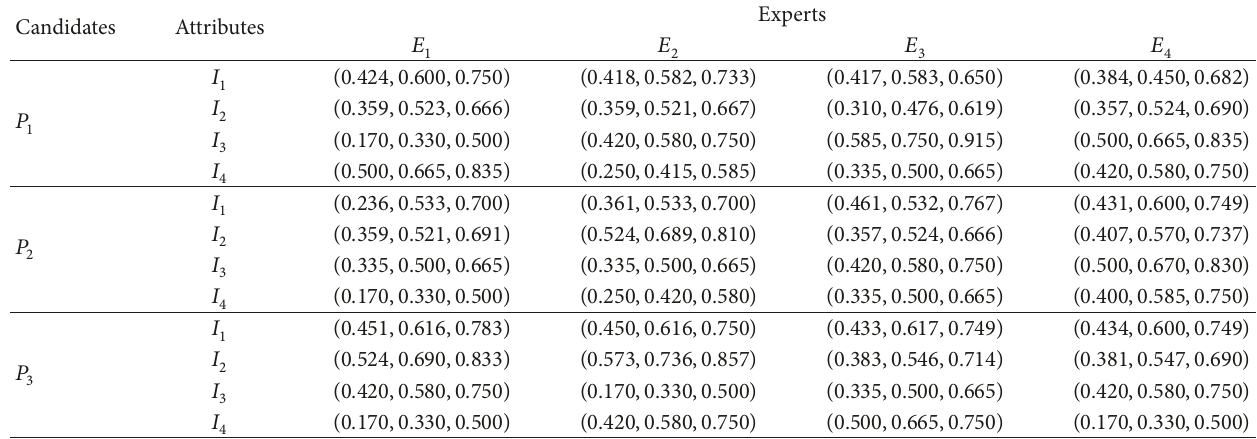
Table 5: Evaluation on competitiveness attributes of candidates given by experts.